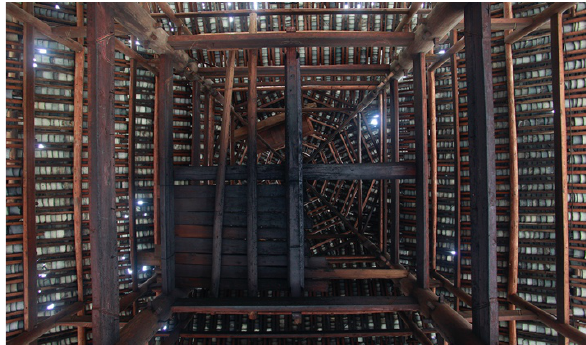
Figure 10 . Timber frame of a typical Chuan-dou Drum